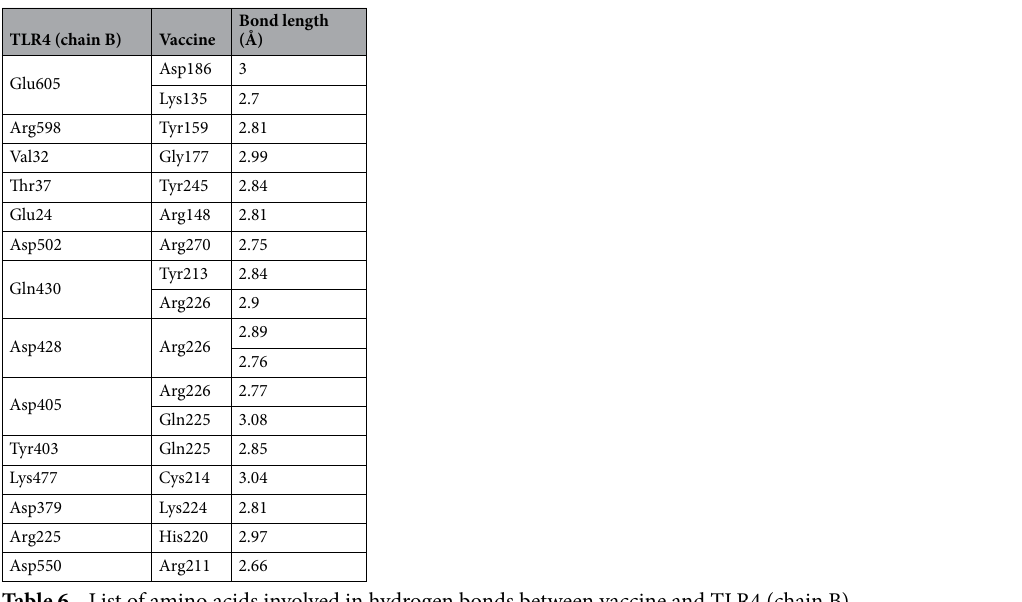
Table 6. List of amino acids involved in hydrogen bonds between vaccine and TLR4 (chain